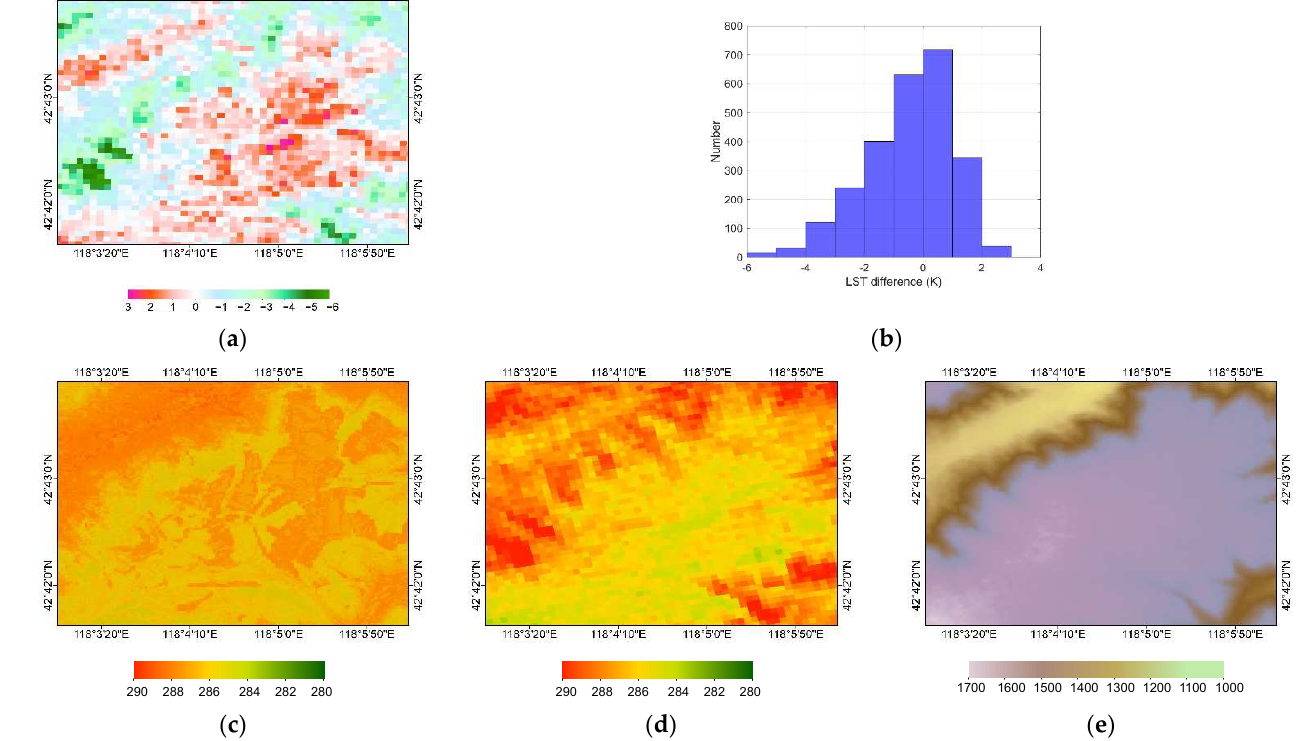
Figure 6. Inter-comparison images for the rugged 30 m LST (aggregated to 90 m) and ASTER-derived 90 m LST. ( a ) The difference between the rugged 30 m LST (aggregated to 90 m) and ASTER-derived 90 m LST; ( b ) the histogram corresponding to the difference image; ( c ) 30 m rugged LST; ( d ) ASTER-derived 90 m LST; ( e ) 30 m DEM.